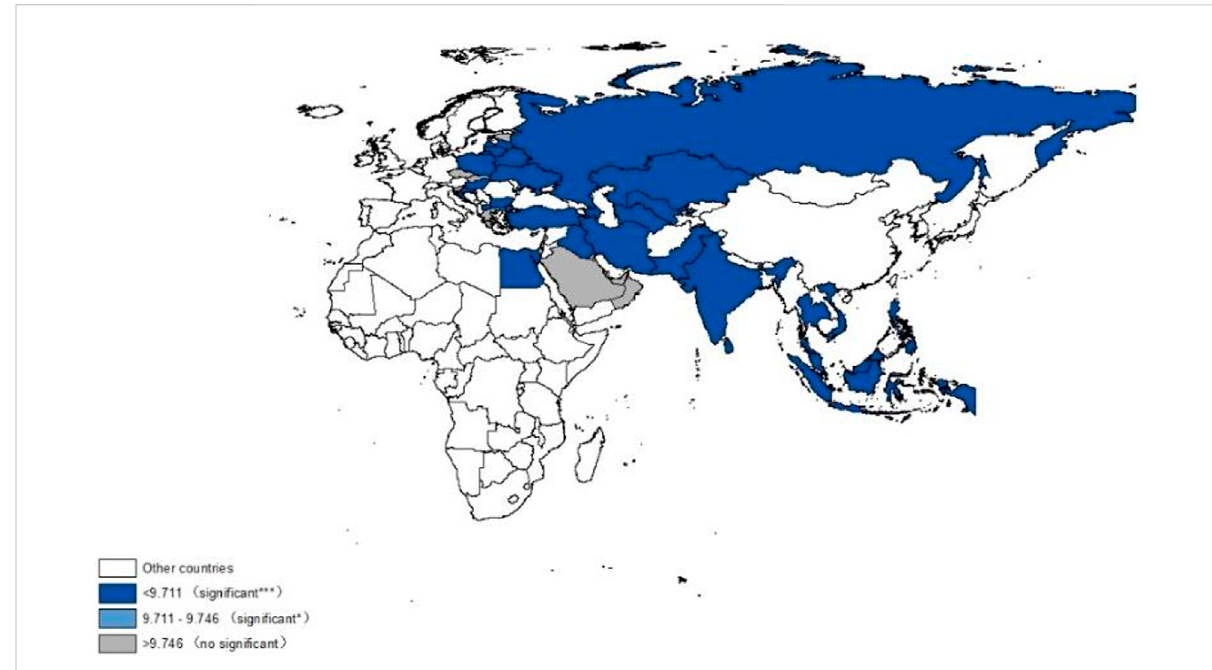
FIGURE 7 Signi fi cance distribution (per capita income level as threshold